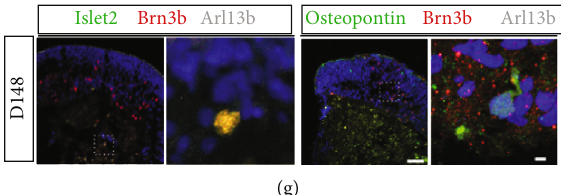
Figure 2: Brn3b-positive RGCs lose primary cilia during later developmental stages of retinal development. (a) Confocal images of retinal organoids show RGCs visualized by Brn3b (red); primary cilia are identi fi ed by costaining for Arl13b (green) and Centrin3 (gray), markers for the ciliary axoneme and basal body, respectively. (b) Quantitative assessment con fi rms that ciliation at days 148 and 176 of retinal organoid development is signi fi cantly reduced compared to day 44. (c) Signi fi cant variations in ciliary length are not observed. (d) Calretinin-positive RGCs are readily identi fi ed by calretinin (green) coexpression with markers for RGCs (Brn3b, gray) and cilia (Arl13b, red). (e) At days 148 and 176 of retinal organoid development, ciliation is signi fi cantly decreased compared to day 44. (f) No signi fi cant changes in ciliary length are observed in calretinin-positive RGCs during retinal organoid development. Nuclei are stained with DAPI (blue). Scale bar: 10 μ m; magni fi ed, 1 μ m. (g) Confocal images of day 148 retinal organoids show RGCs visualized by Brn3b (red), RGC subtype markers by Islet2 or Osteopontin (green), and primary cilia by Arl13b (gray).